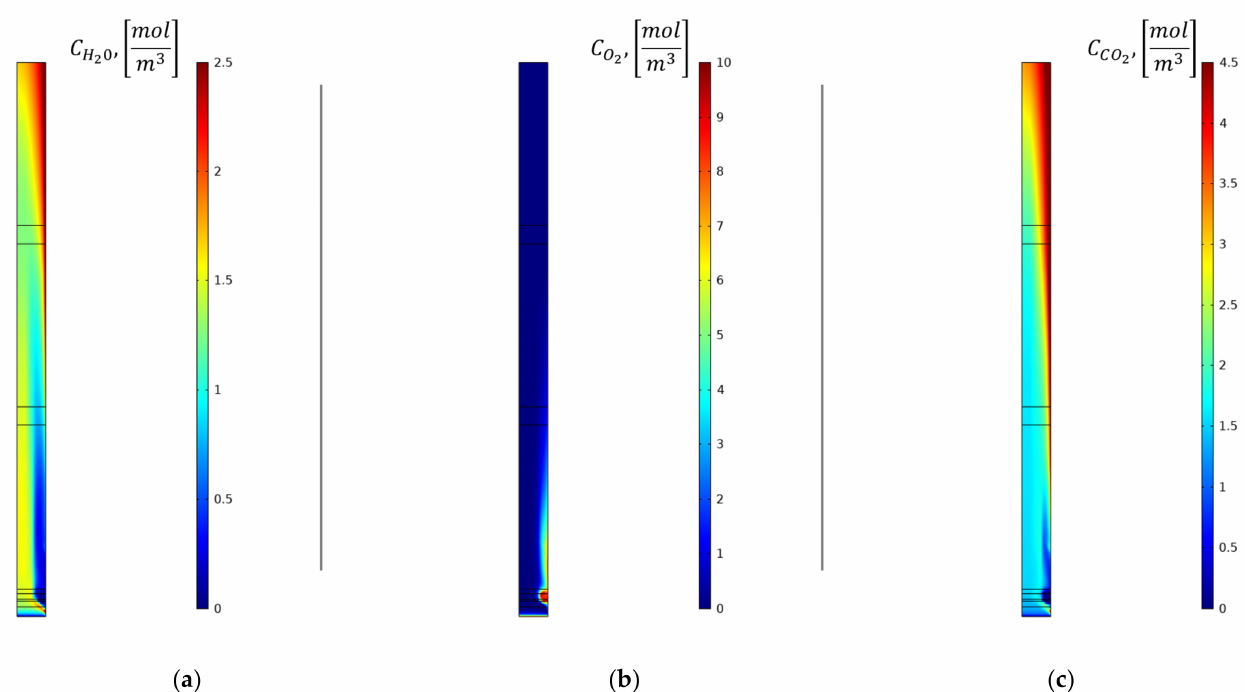
Figure 11. Distribution of fields when using MW pre-treated straw pellets T MW = 473 K: concentration of ( a ) H 2 O, ( b ) O 2 , ( c ) CO 2